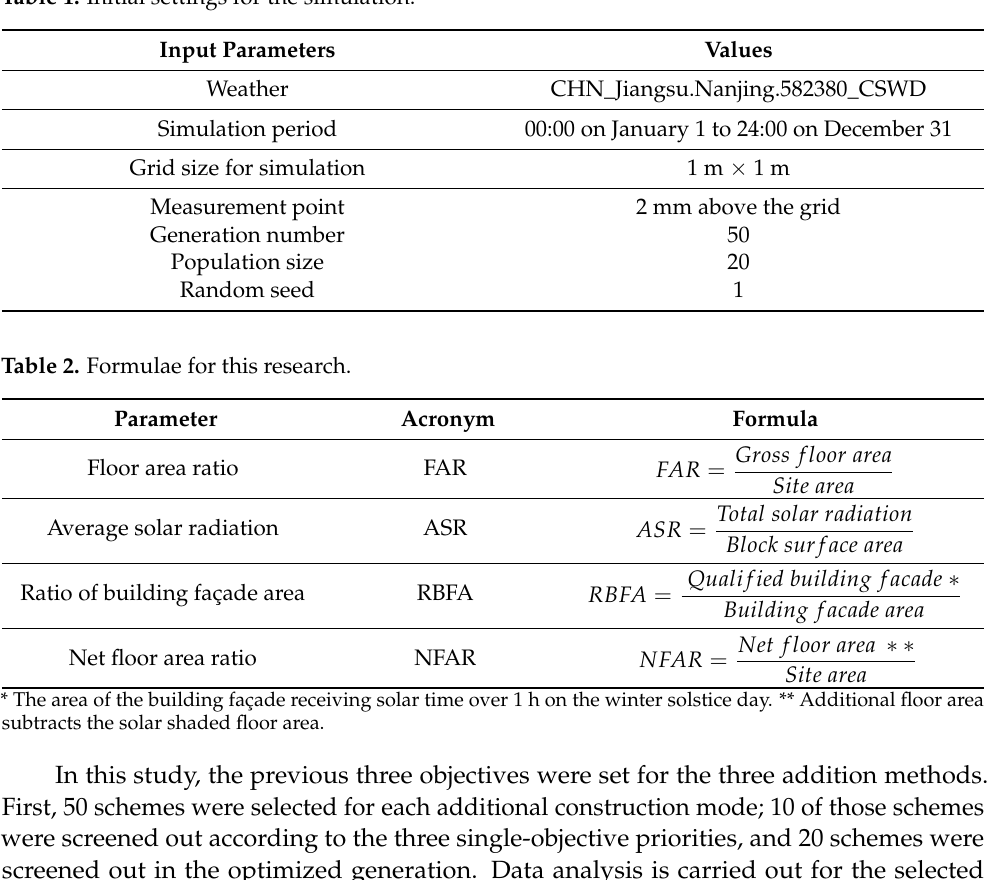
Table 1. Initial settings for the simulation.